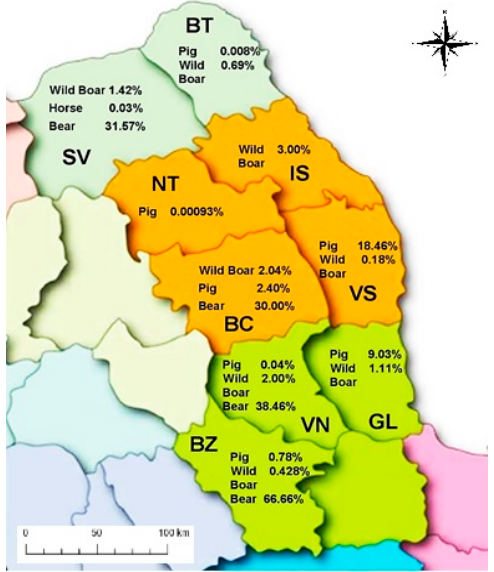
Figure 2. Geographical distribution and prevalence of positive samples for Trichinella infection in animals in North-Eastern Romania (2010–2015).